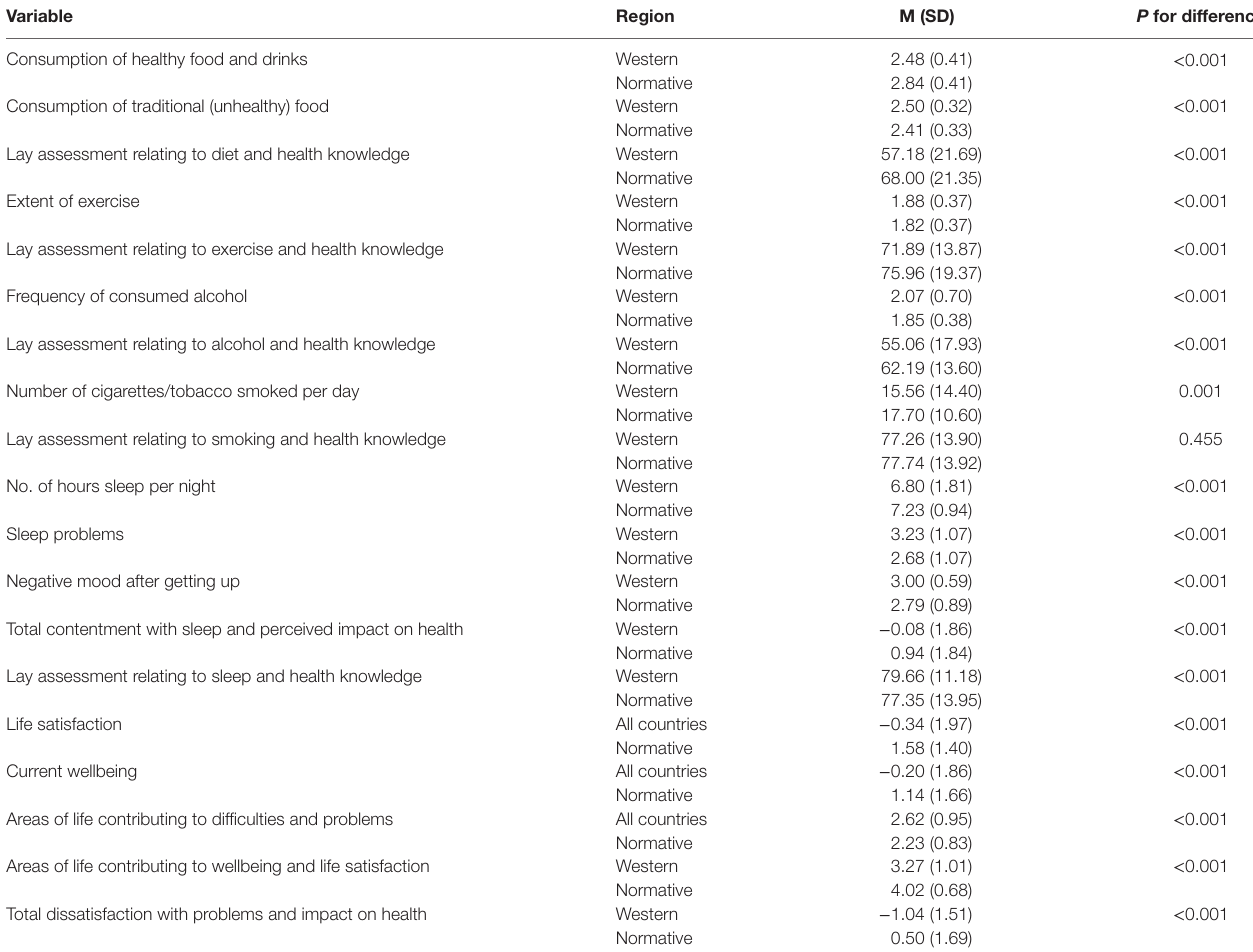
TaBle 3 | comparison of samples with mental illness (all countries N = 672; Western sample n = 479) and normative sample ( N = 1,019).